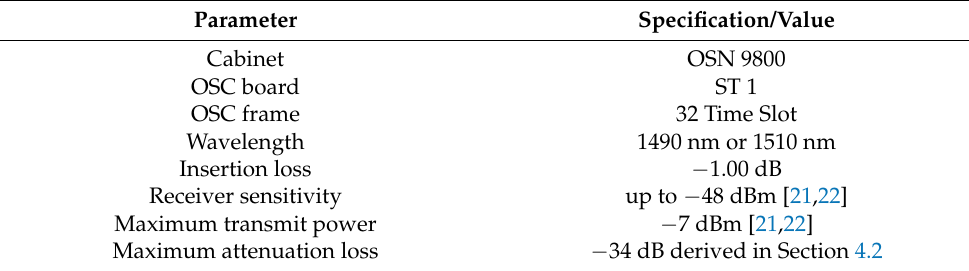
Table 3. The specifications and parameters of OSC